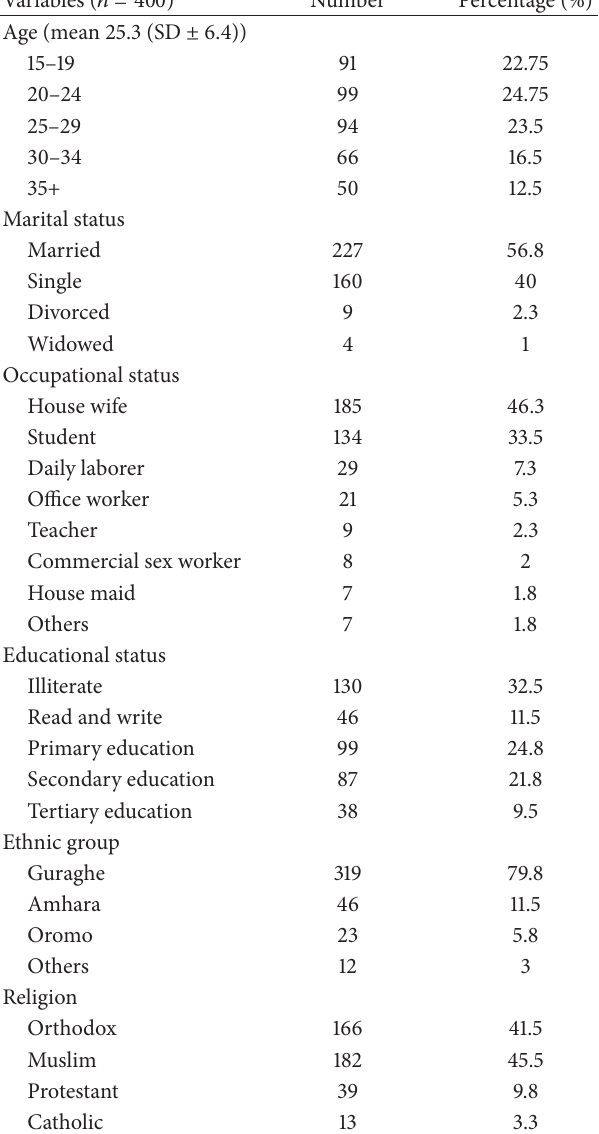
Table 1: Sociodemographic characteristics of postabortion patients in health institutions of Guraghe zone, South Ethiopia, from January to March,